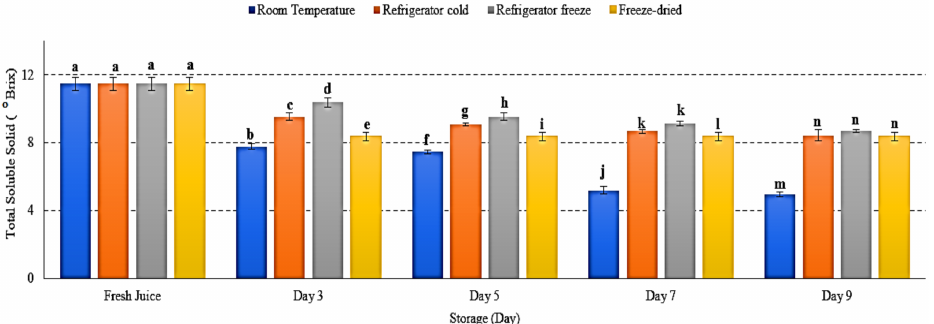
Figure 5. The total soluble solid of watermelon juice during 9 days of storage. Different letters indicate significant differences between samples p <